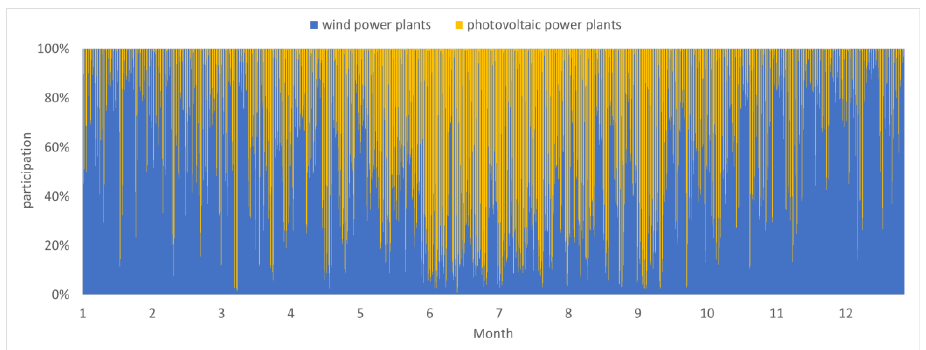
Figure 6. Share of photovoltaic and wind power plants in generation of renewable energy sources in Poland in 2021 (own compilation of data from PSE S.A.).